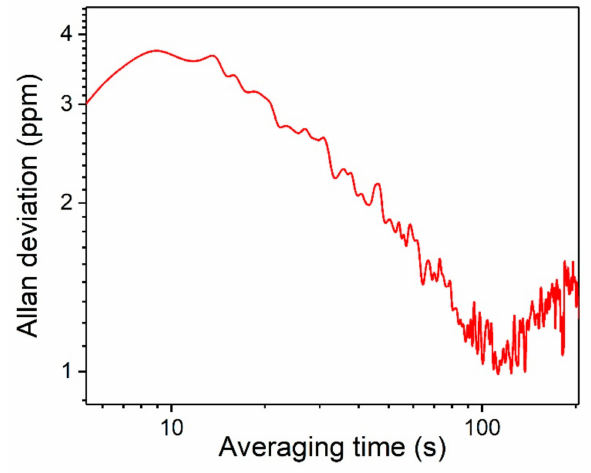
Figure 6. Allan deviation analysis for the FW-QCL based CO 2 sensor system.